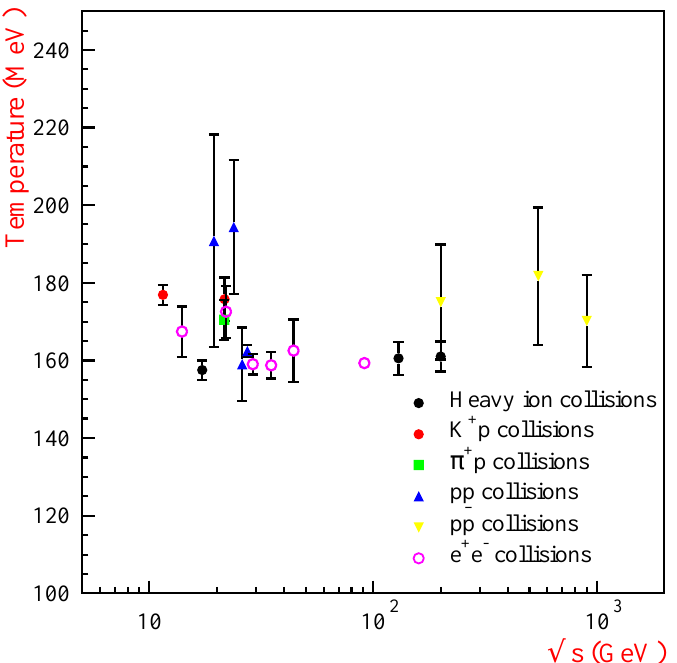
Figure 2. Hadronization temperatures obtained for various initial collision configurations at different (high) energies.